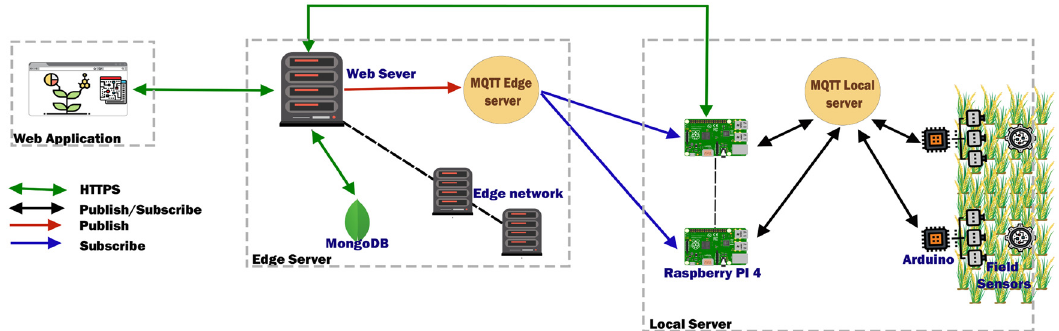
Figure 5: Proposed edge communication